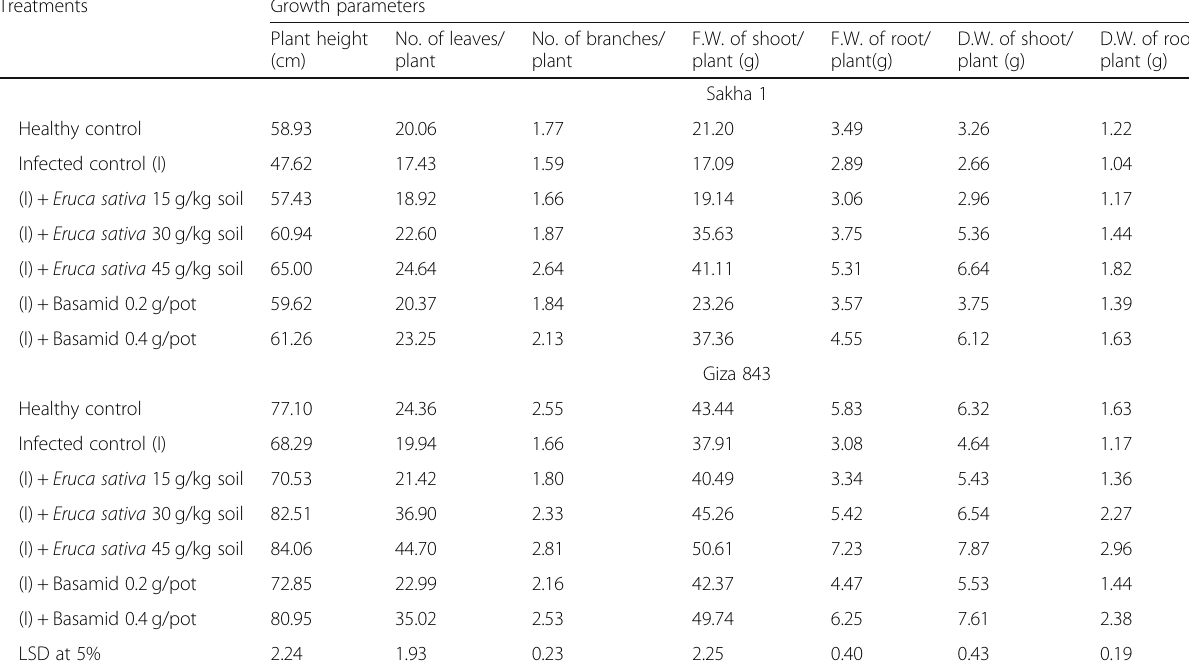
Table 3 Effect of different concentrations of Eruca sativa L. seed powder and Basamid herbicide on growth parameters of two Vicia faba L. cultivars at 90 days after sowing (combined analysis of two seasons) Treatments Growth